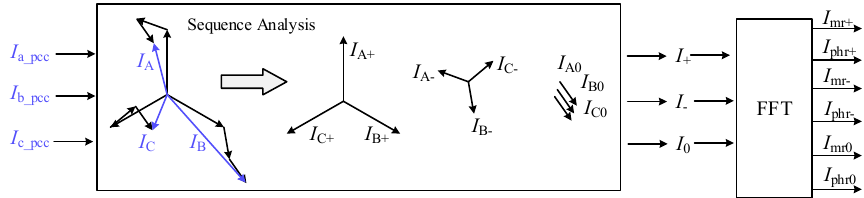
Figure 5. Imbalanced Current Detection and Reference Signal Generation.